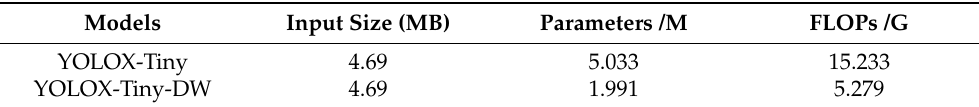
Table 2. Improved network model size based on depth-wise separable convolution.